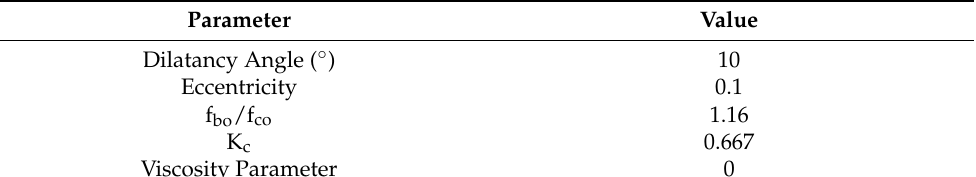
Table 2. Mechanical parameters of the CDP model.